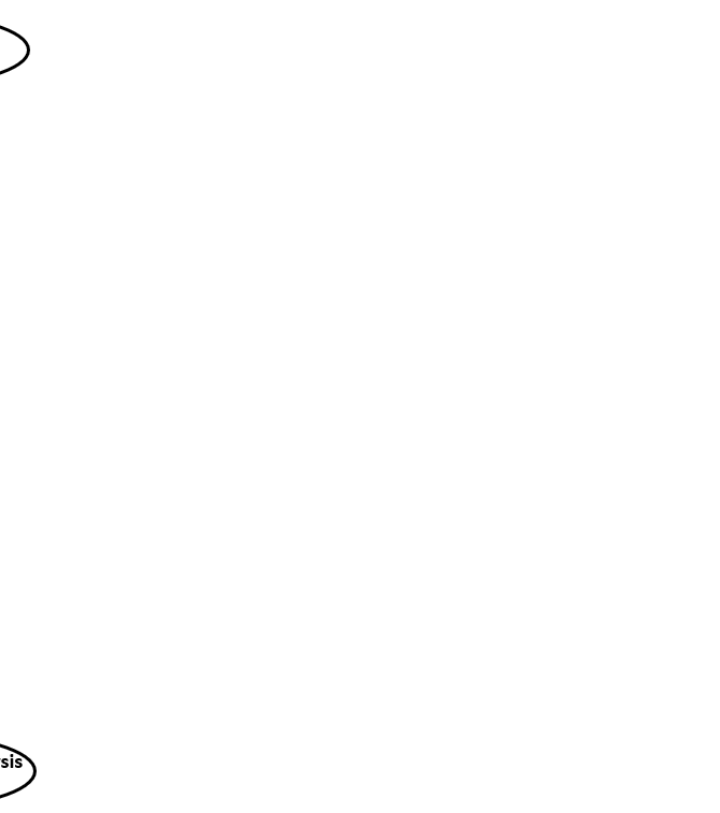
Figure 1. Competency-oriented flowchart. Modeling and